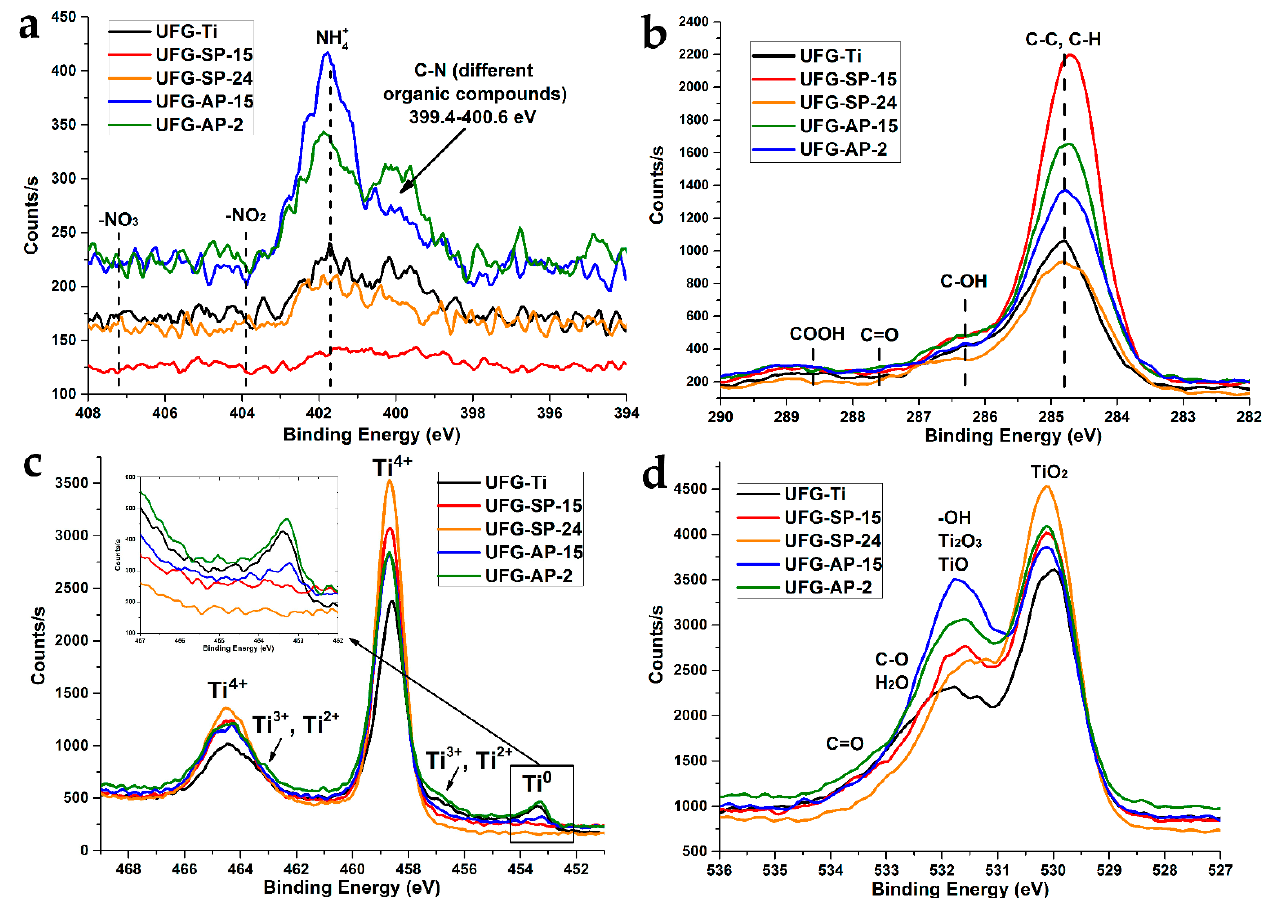
Figure 2. XPS spectra of polished and chemically etched UFG titanium: ( a ) N1s; ( b ) C1s; ( c ) Ti2p; ( d ) O1s. Table 2. Percentage of Ti forms based on Ti2p spectra